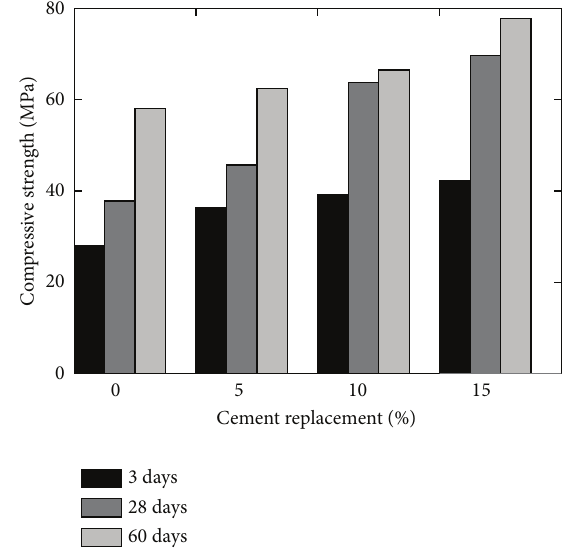
Figure 10: Effect of cement replacement on the compressive strength of MK concrete (w / b = 0.38 )